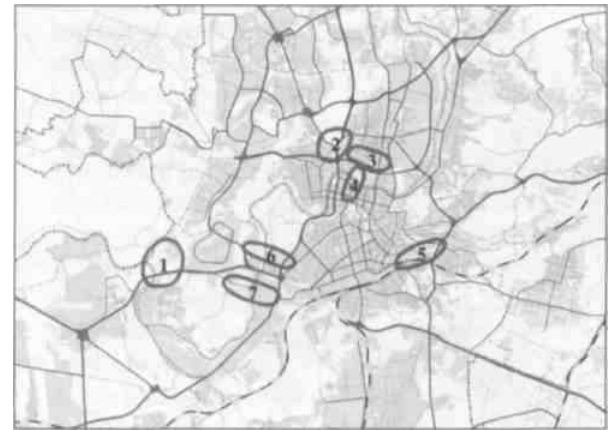
Fig 1. Street network foreseen in the Comprehensive Plan of Vilnius and operative planning works by Vilniaus Planas in